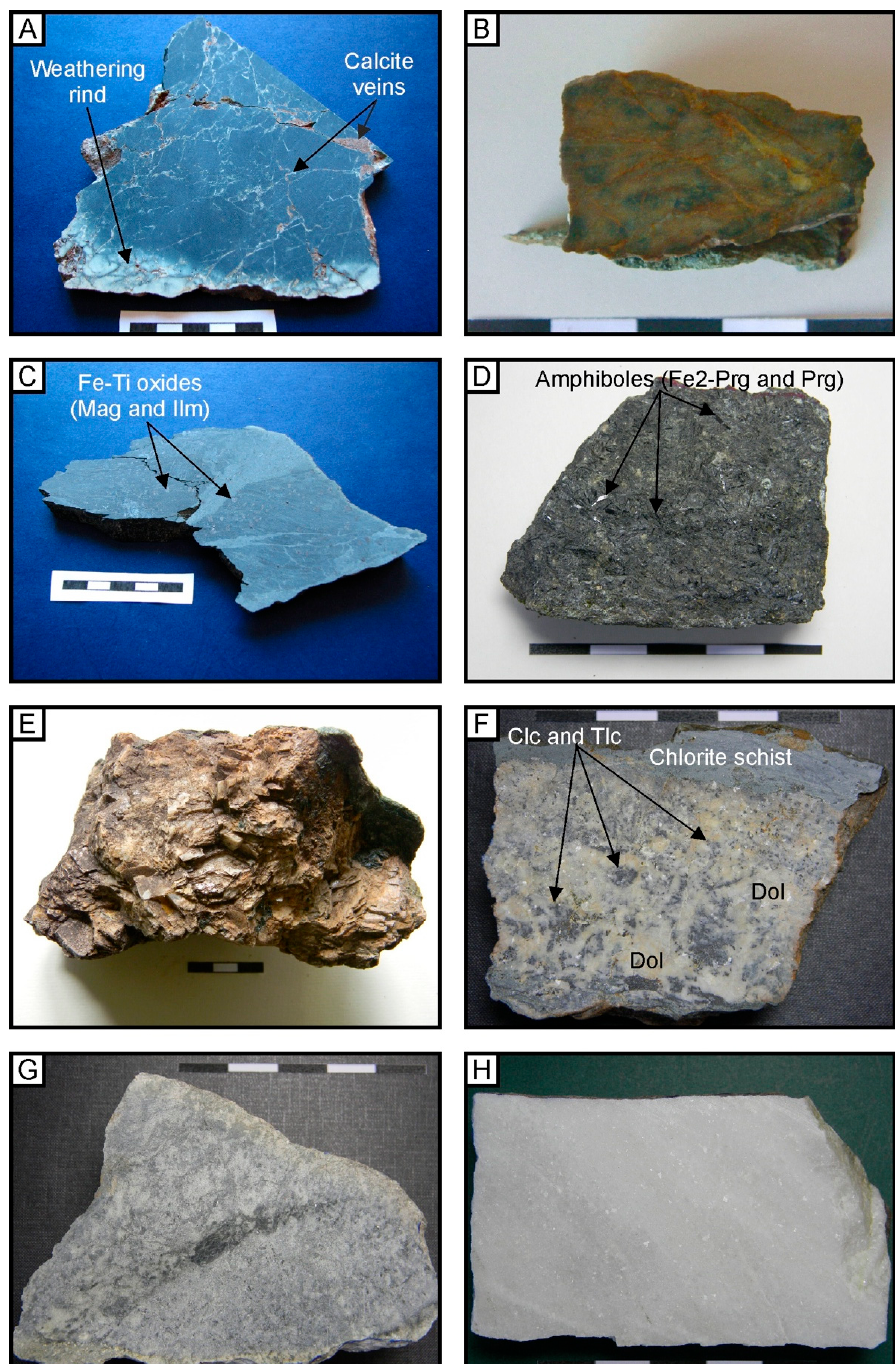
Figure 5. Hand-specimen photographs. ( A ) Serpentinite sample KL-4 with visible creamy weathering rind; ( B ) Brownish colored talc schist; ( C ) Chlorite schist (KL-5) with macroscopically visible magnetite and ilmenite crystals; ( D ) Coarse-grained hornblendite sample, most abundant in Fe, Ti, V and Cu (KL-1); ( E ) Barren dolomite vein (KL-3) with visible coarse dolomite crystals and contact with chlorite schist; ( F ) Mineralization-bearing dolomite vein (KL-3C); ( G ) Medium- to coarse-grained barren metagabbro (KL-2); ( H ) Calcic Bia ł a Marianna marble (KL-12) from quarry near the Jaskinia Nied ź wiedzia (the Bear Cave). Abbreviations: Clc—clinochlore, Dol—dolomite, Fe2-Prg—ferro-pargasite, Ilm—ilmenite, Mag—magnetite, Prg—pargasite, Tlc—talc. The scale bar length is: 5 cm—( A , C ); 10 cm—( B,D,F–H ); 3 cm—( E